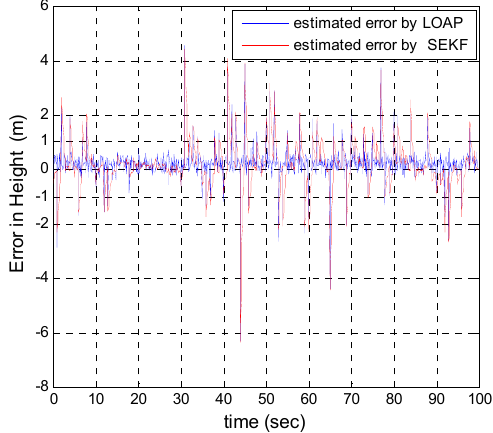
Figure 15. Error estimation of height.